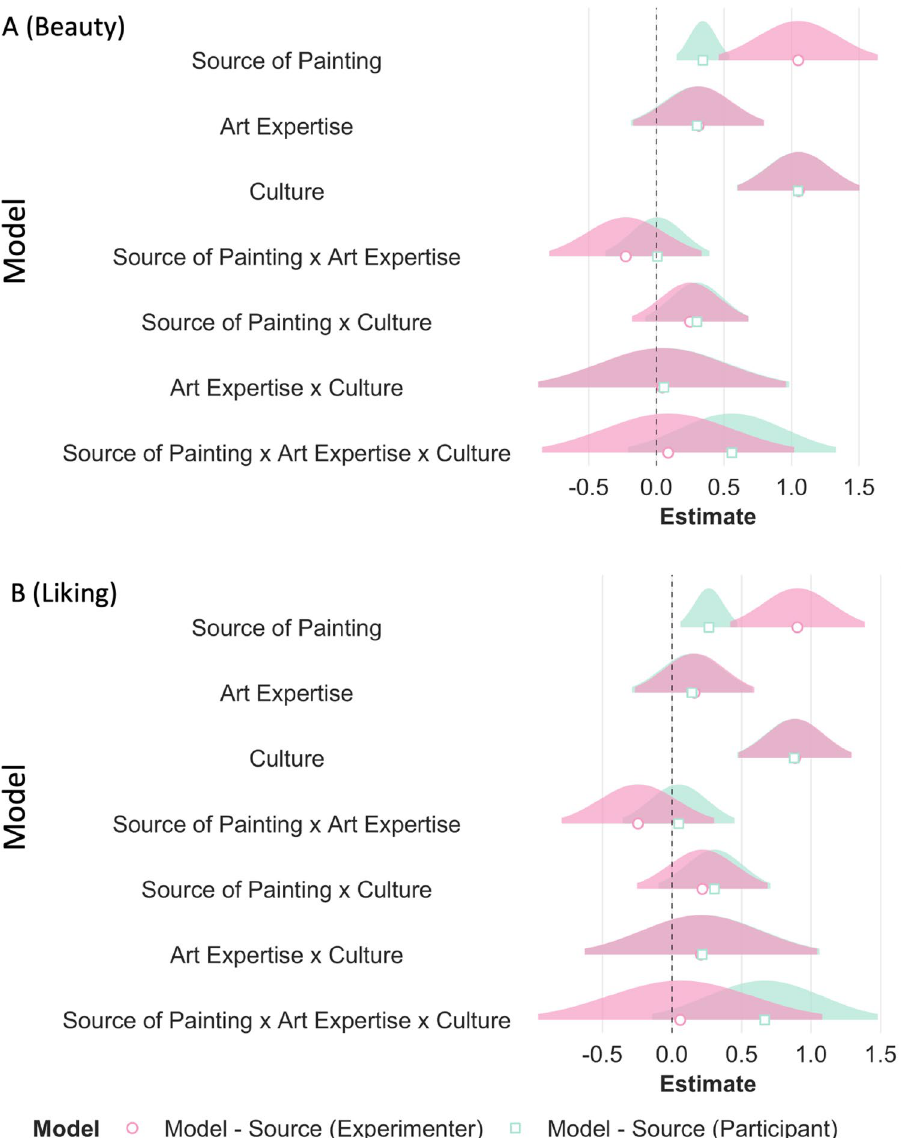
Figure 9. For the outcome variables of beauty ( A ) and liking ( B ), beta estimates for the model with source of painting as categorized by the experimenter (in pink) and the model with source of paintings as categorized by the participant (in green) are plotted for each predictor variable along with their corresponding uncertainties (95% confidence interval width for a normal distribution for each estimate). Distributions are rescaled to match the height of each